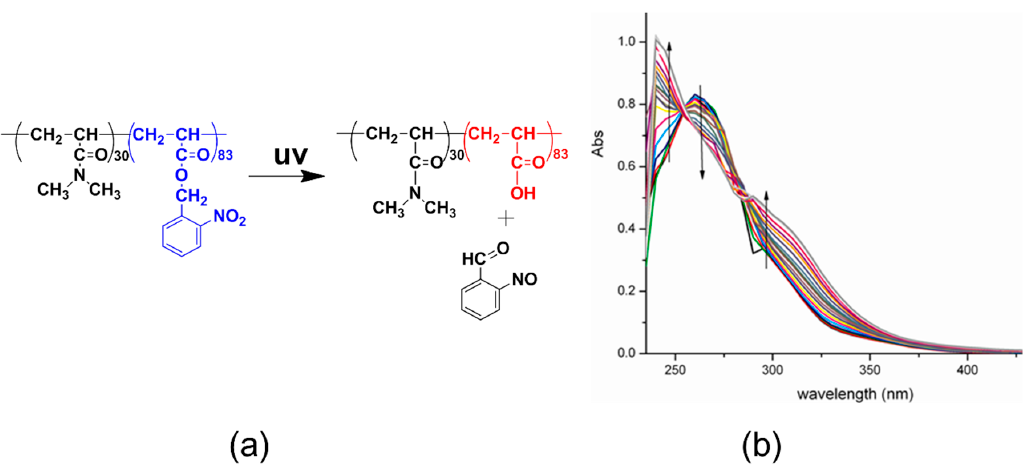
Figure 2. Photocleavage reaction of PDMA 30 -b- PNBA 97 upon exposure to light irradiation at 365 nm. ( a ) Schematic of the photocleavage of the polymer showing the cleavage product and the shift of hydrophobic and hydrophilic balance; ( b ) UV-vis spectra of the polymer solution in THF with different irradiation times. PDMA 30 -b- PNBA 97 : N,N’ -dimethylacrylamide 30 -b-o-nitrobenzyl acrylate 97 .